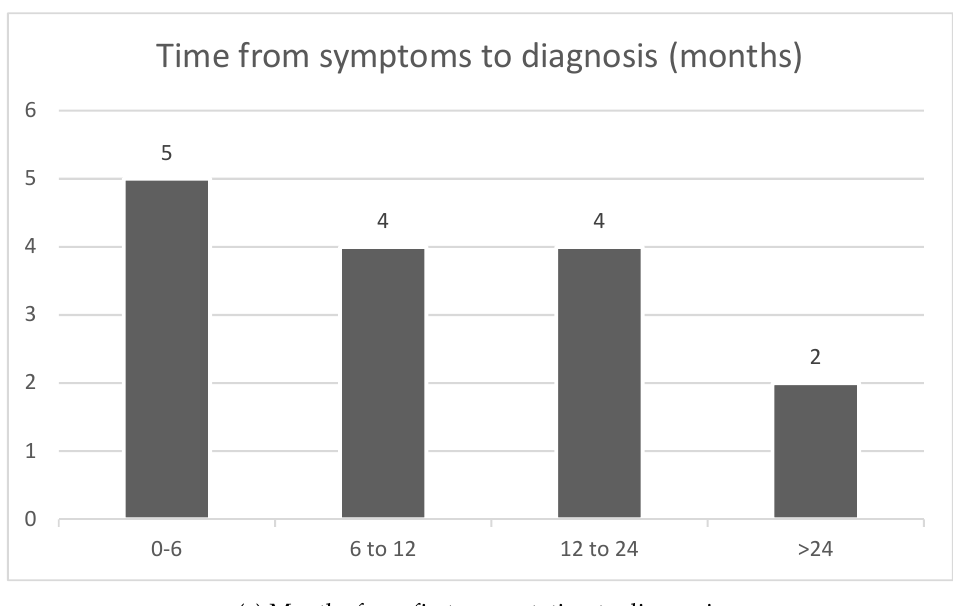
Figure 6. Clinical features of IgG4 related mastoiditis.